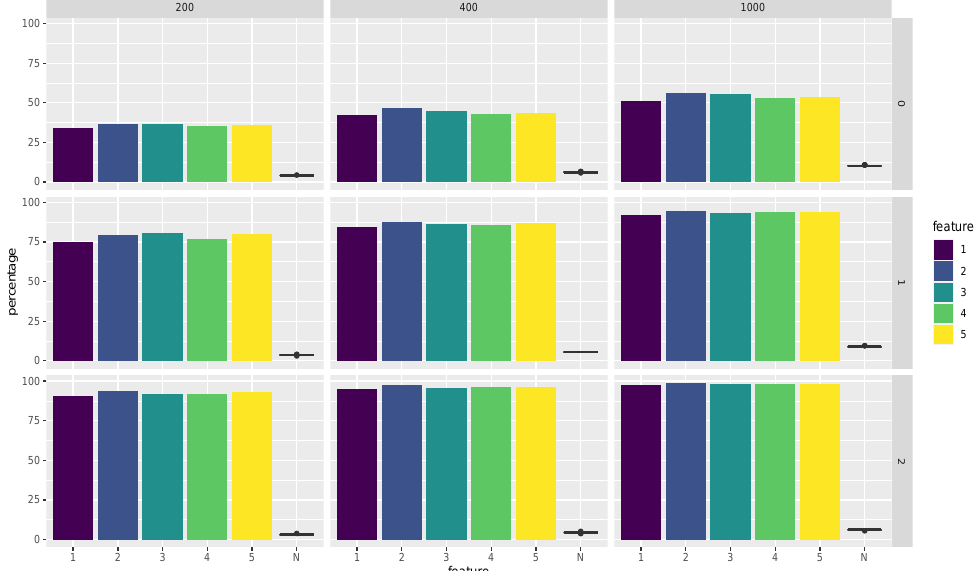
Figure 6. The average selected proportion for each feature for different sample sizes (corresponding to each column) and iteration number (corresponding to each row) in Model 3